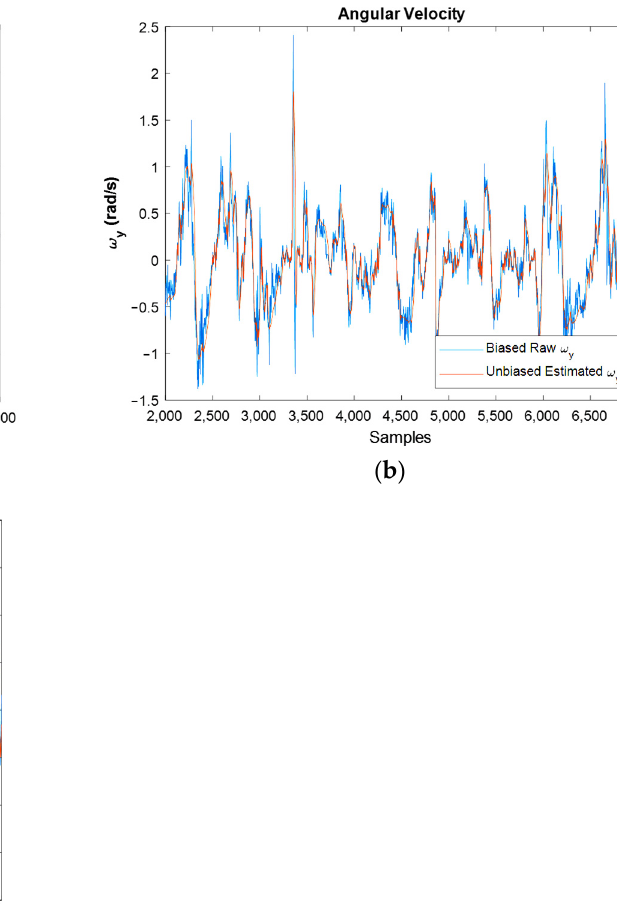
Figure 12. Estimated orientation for moving IMU by representing roll, pitch, and yaw angles for all samples ( a ), and for the last estimated value in each sampling rate ( b ).